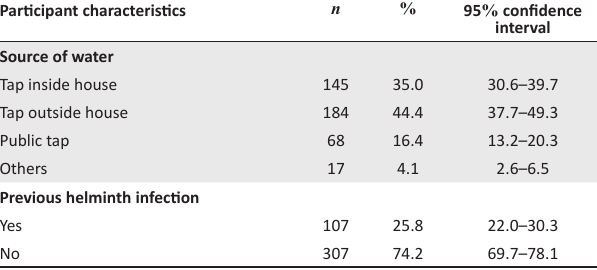
TABLE 1 (Continues...): Demographic profiles of study